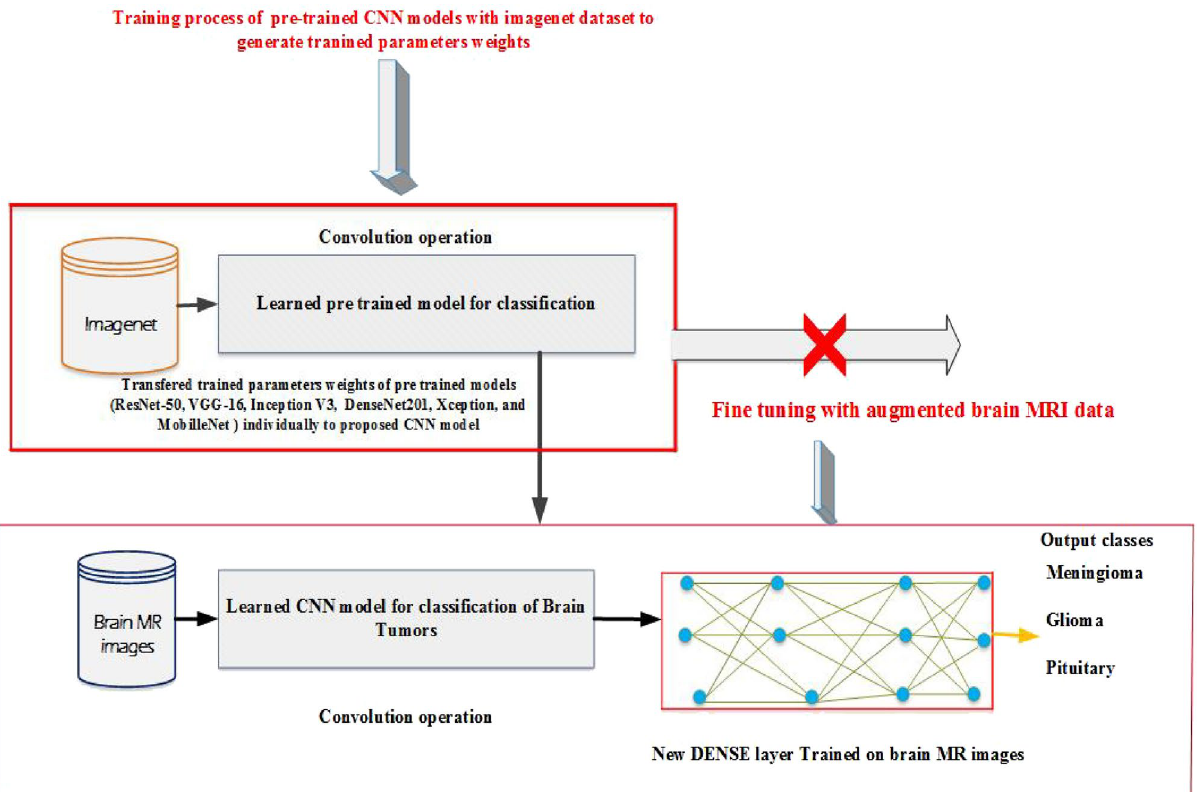
Figure 2. Flow chart of proposed tumor classification framework in IoT healthcare systems. The pre trained CNN models (ResNet-50, VGG-16, Inception V3, DenseNet201, Xception, and MobilleNet) are trained with image-net dataset and the generated weights of these pre trained models are individually transferred to proposed CNN model for effective training. While the augmented data set is used for fine-tuning of the ResNet- CNN model for final classification of brain